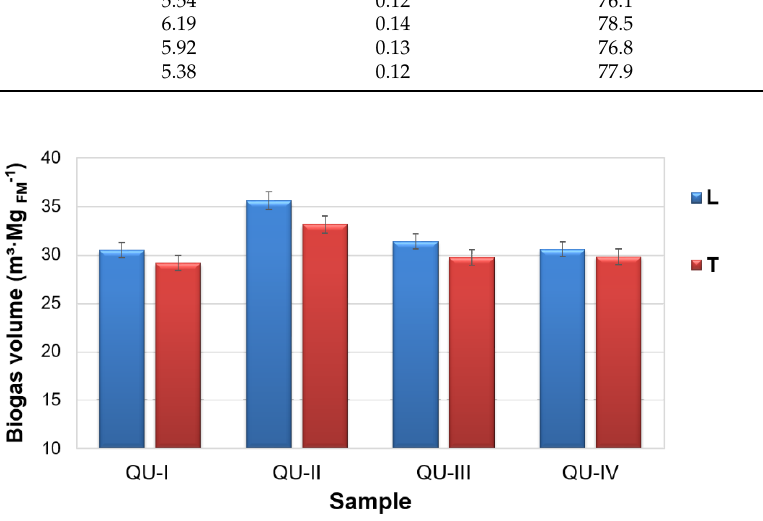
− 1 (L—laboratory scale; T—technical scale). 3 · Mg FM